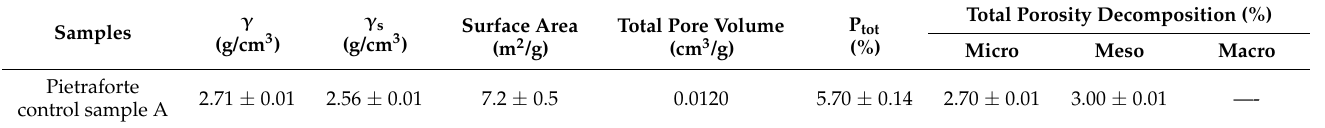
Table 4. Textural properties of Pietraforte control sample (the untreated sample